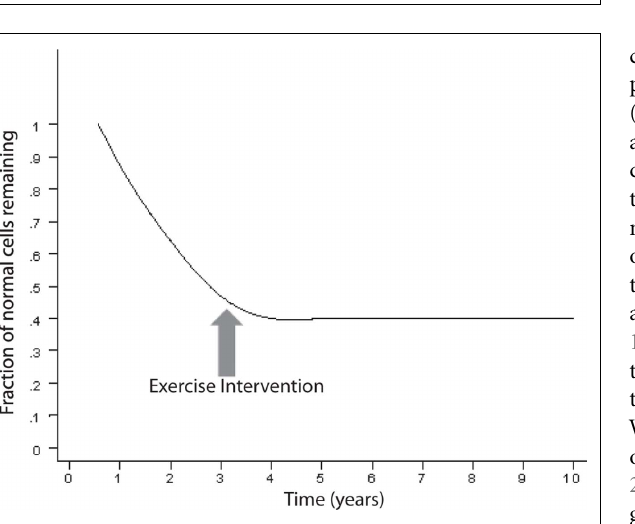
FIGURE 2 | Curve describing the kinetics of neuronal death in neurodegenerative diseases based on an animal model (adapted; Clarke et al., 2000). There is an exponential decline of neuronal number in time.